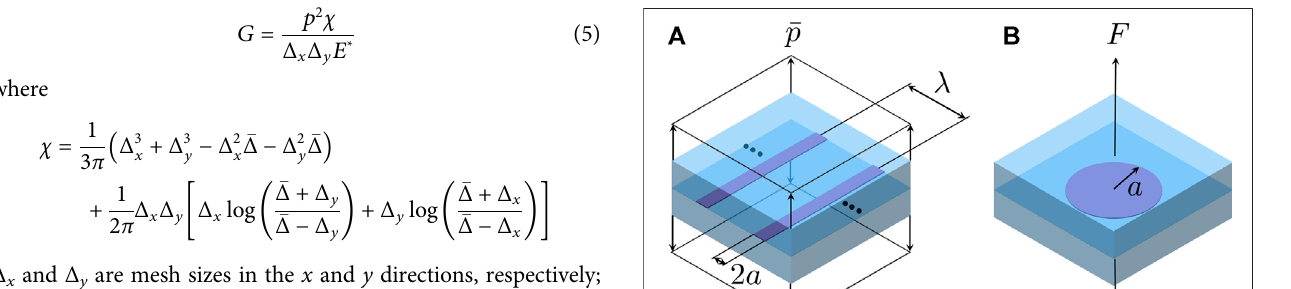
are subjected to a tensile normal traction (cid:1) p at far end, see Figure 2A . This classic problem was solved analytically by